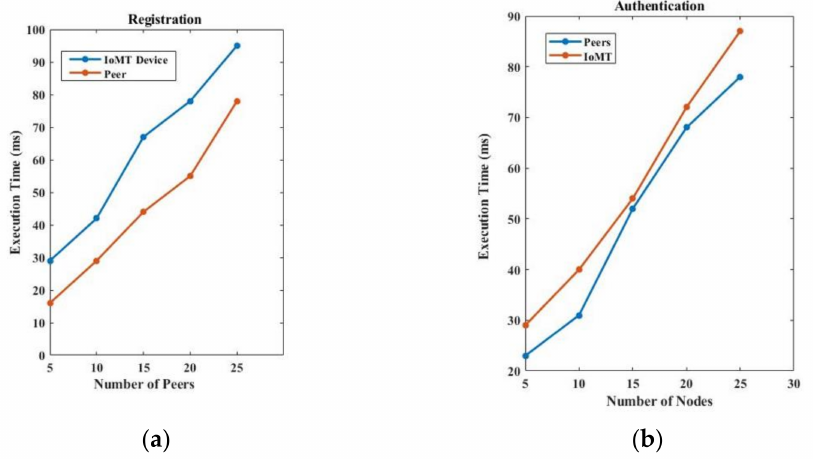
Figure 6. ( a ) Registration and ( b ) authentication time of stakeholders and IoMT devices.